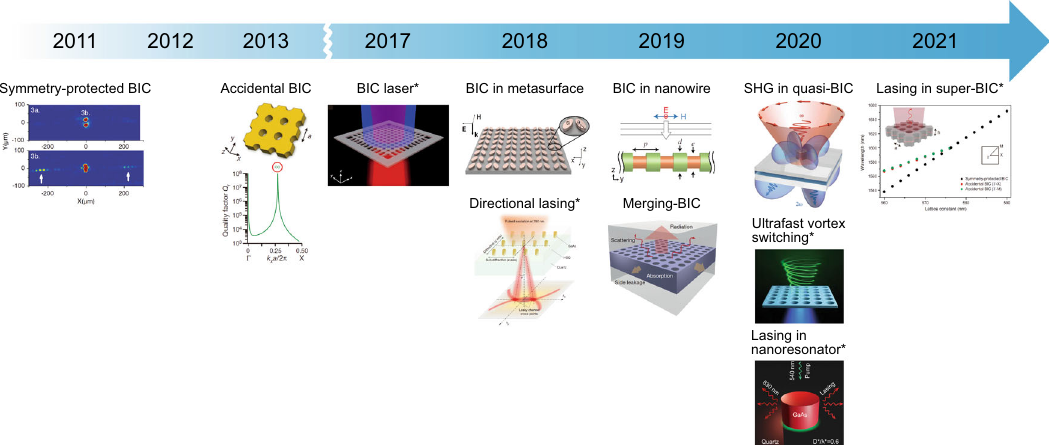
Fig. 1 Brief timeline of passive and active bound states in the continuum (BICs). Experimental demonstrations of optical BICs have been extensively reported since 2011. SHG stands for second-harmonic generation. Reprinted by permission from ref. 15 , copyright 2011, reprinted by permission from ref. 16 , copyright 2013, reprinted by permission from ref. 17 , copyright 2017, reprinted by permission from ref. 18 , copyright 2018, reprinted by permission from ref. 19 , copyright 2018, reprinted by permission from ref. 20 , copyright 2019, reprinted by permission from ref. 21 , copyright 2019, reprinted by permission from ref. 22 , copyright 2020, reprinted by permission from ref. 23 , copyright 2020, reprinted by permission from ref. 24 , copyright 2020, and reprinted by permission from ref. 25 , copyright